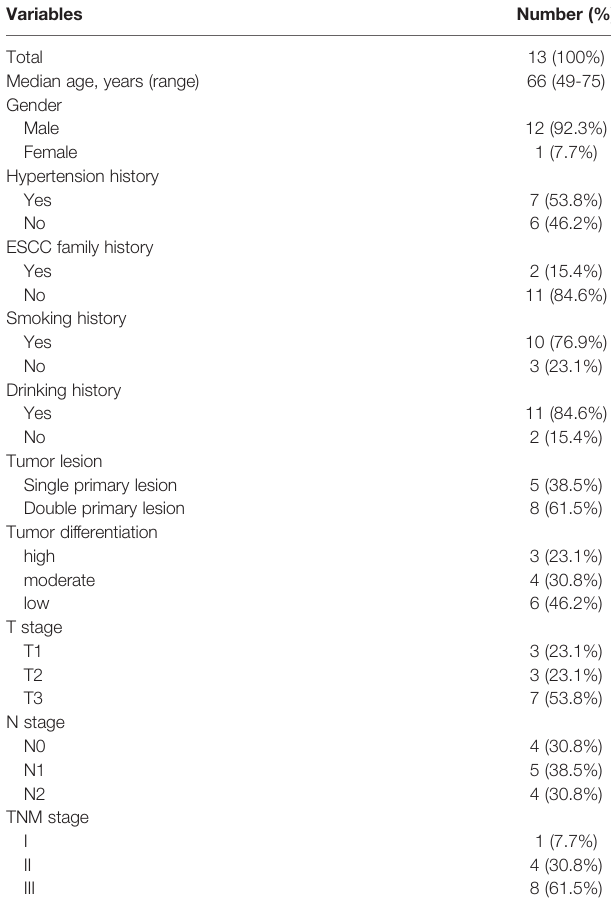
TABLE 1 | Baseline characteristics of ESCC patients enrolled in this study.